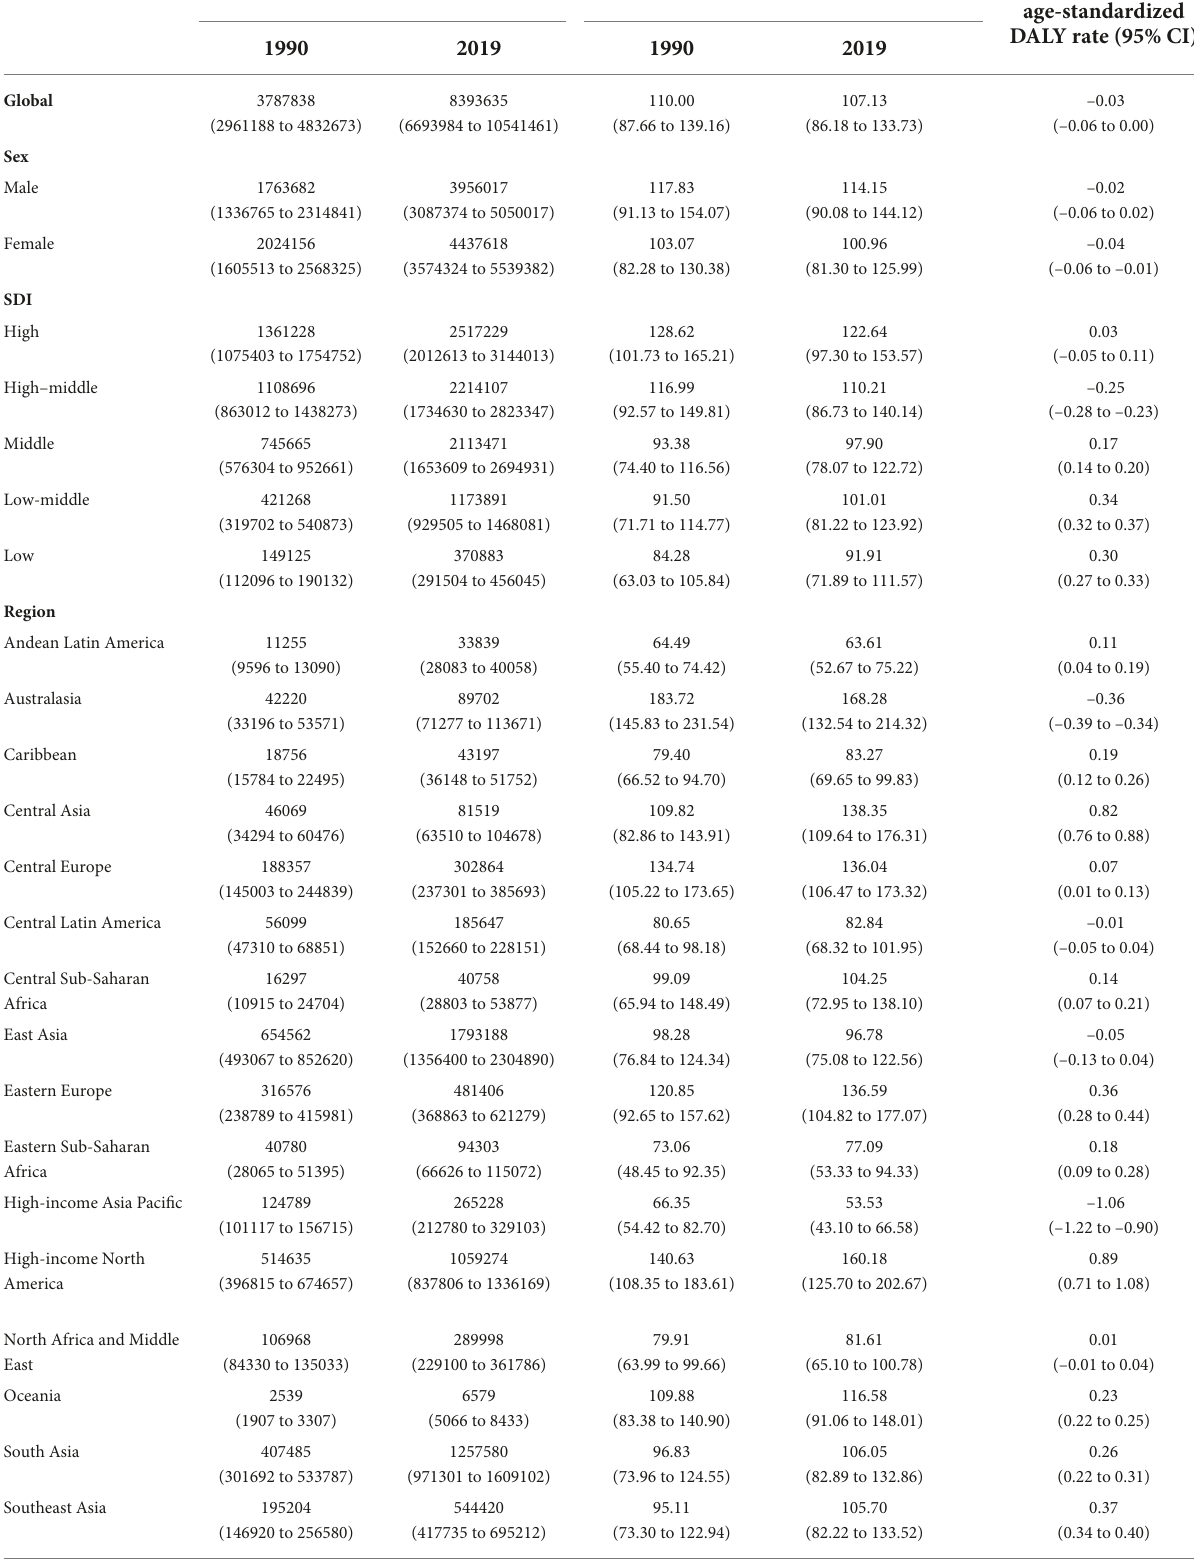
TABLE 3 The DALYs of atrial fibrillation in 1990 and 2019, and its temporal trends from 1990 to